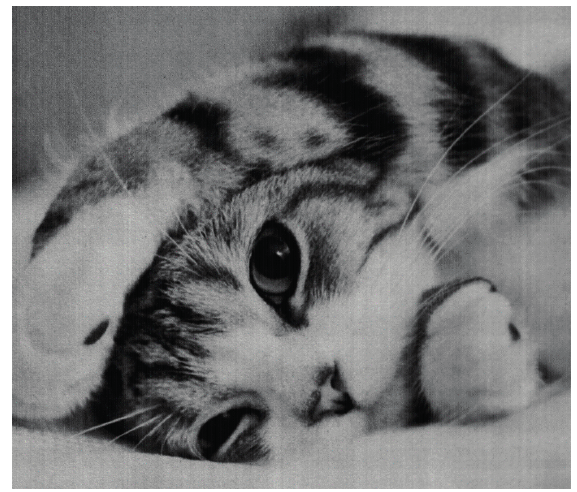
Figure 22. Sample image with 10-bit